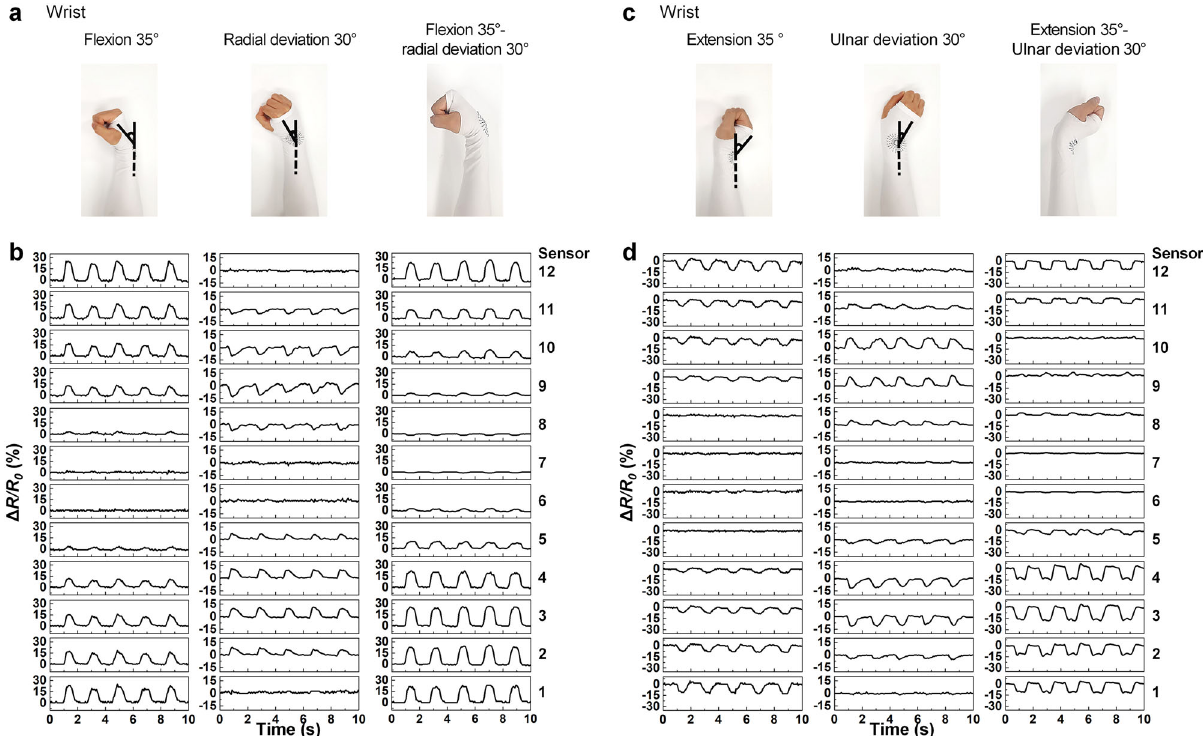
Fig. 7 Monitoring wrist motion at various rotational angles. Wrist positions during the evaluation are indicated in panels ( a ) and ( c ). Electrical characteristics obtained with the fi ber arrayed fabric sensor b while monitoring wrist fl exion (35°), radial deviation (30°), and fl exion (35°)-radial deviation (30°), and d during extension (35°), ulnar deviation (30°), and extension (35°)-ulnar deviation